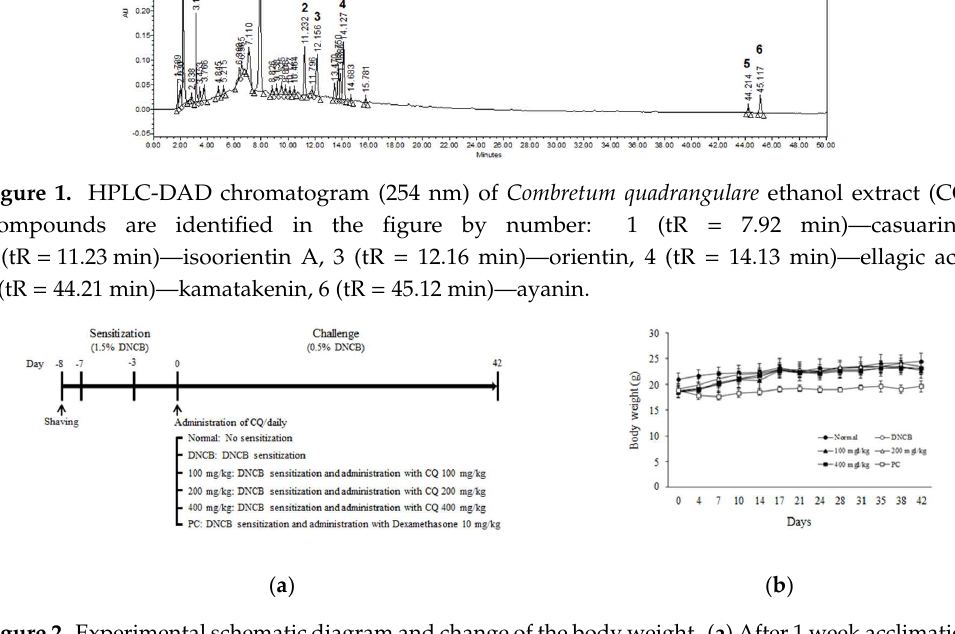
Figure 2. Experimental schematic diagram and change of the body weight. ( a ) After 1 week acclimation, the dorsal part to induce AD-like skin lesions was removed. The shaved dorsal skin was sensitized with 200 µ L application of 1.5% 1-chloro-2,4-dinitrobenzene (DNCB) dissolved in mixture of acetone / corn oil (3:1). Thereafter, 150 µ L application of 0.5% DNCB was challenged 3 times a week for 6 weeks. The mice were randomly divided into six groups with 10 mice per group (5 mice per cage): normal, DNCB, DNCB + CQ (100, 200, and 400 mg / kg) and DNCB + PC 10 mg / kg. CQ was orally administered for 6 weeks; ( b ) Mice of all groups were provided food and water ad libitum for the experiment. The body weight change was recorded twice a week.